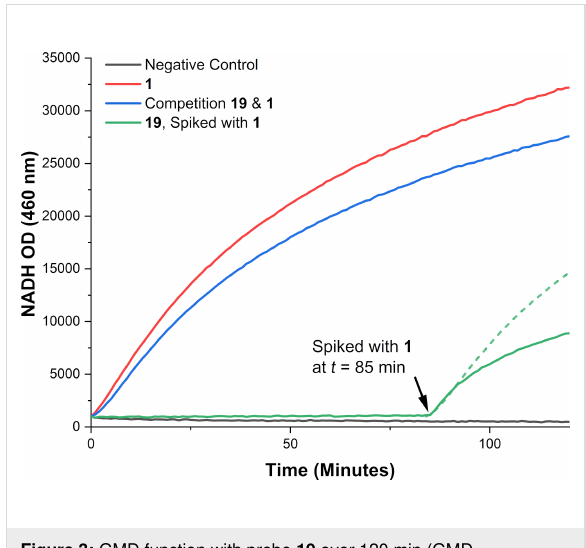
Figure 3: GMD function with probe 19 over 120 min (GMD (100 µg/mL), GDP sugars (50 µM), NAD + (200 µM)). Dotted trace dictates expected fluorescence output following spiking with GDP-Man 1 if GMD activity fully restored (or probe 19 was not an